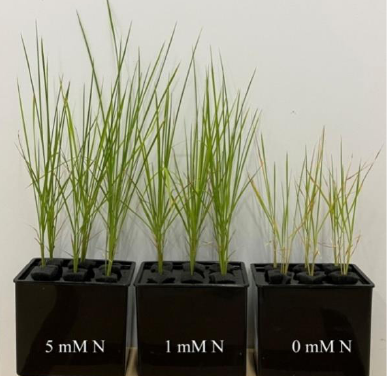
Figure 1. Phenotypeof O. sativa seedlings under different N levels. Rice seedlings were transplanted to the Hogland nutrient solution containing 5 mM (control), 1 mM (low N), and 0 mM NH 4 NO 3 (N deficiency). Seedlings were kept under a 14 h light/10 h dark regime with white photo-illumination of 150 μmol m -2 s -1 as well as a relative humidity of 68% in a light incubator (28 °C). Fi f teen days after transplanting, leaf and root samples were collected.